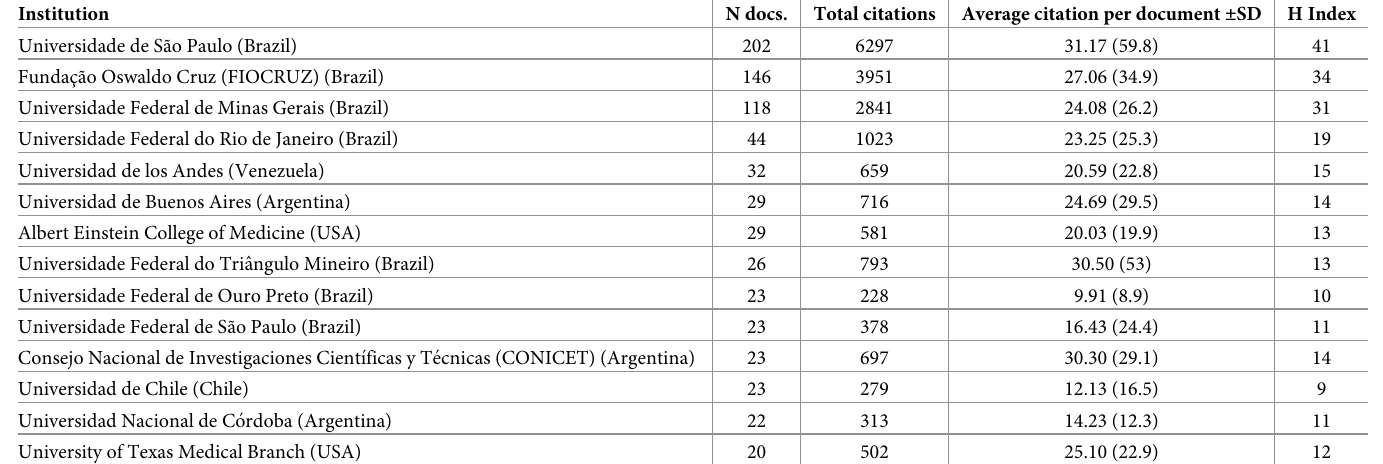
Table 3. Citation indicators of the most productive institutions on Chagas